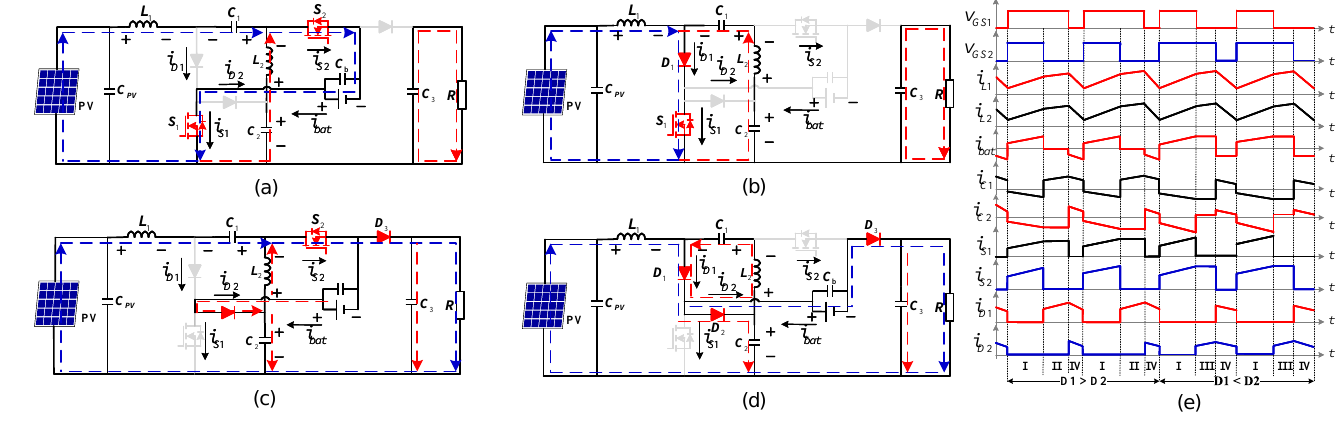
Figure 3. Equivalent circuits of the proposed TPC in ( a ) State I, ( b ) State II, ( c ) State III, and ( d ) State IV. ( e ) Waveforms of key